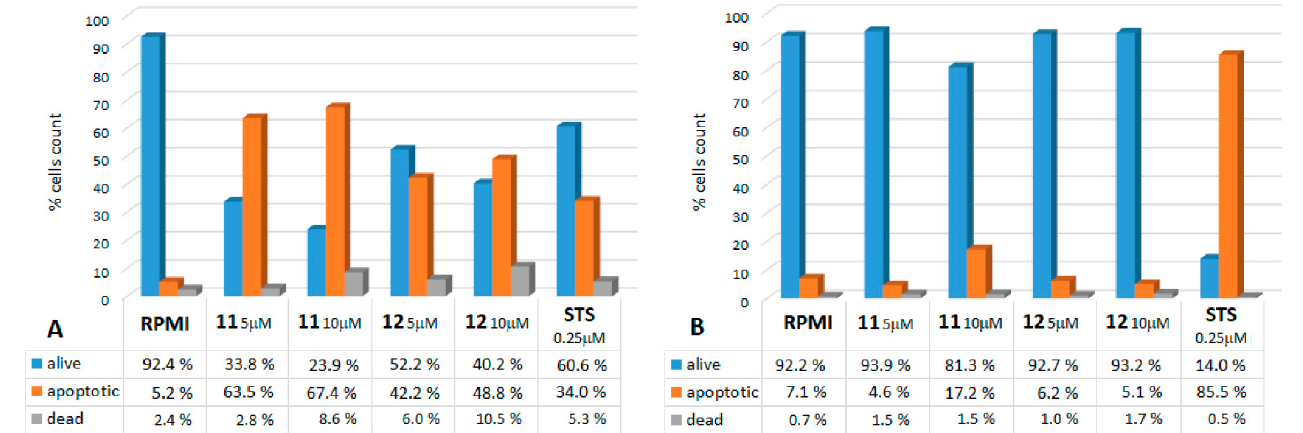
Figure 5. Apoptosis induction: annexin V assay. The graphs show the results on the ( A ) melanoma cells (SK) and ( B ) control fibroblasts (BJ) following a 16-h treatment with 11 and 12 at concentrations of 5 and 10 μ M. The data represent the percentage of alive, apoptotic (early + late), and dead cells after 16 h from the administration of the compounds. Staurosporin (STS) at a 0.25- μ M dose was used as an apoptosis inducer, the positive control.